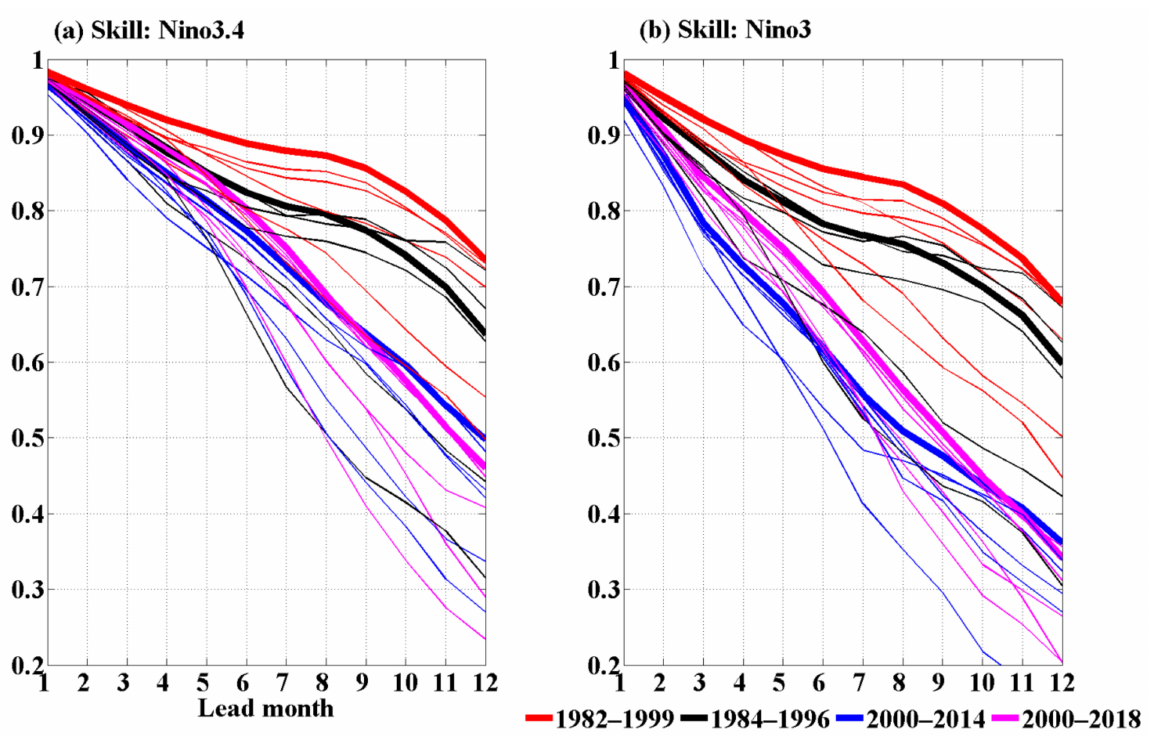
Figure 1. Temporal correlation between the multimodel ensemble (MME) forecasts and the observations for all of the months combined as a function of lead time for ( a ) the Niño3.4 index and ( b ) the Niño3 index for the four periods. (The thick solid lines indicate MME results and the thin solid lines indicate the results of the five individual models. The different colors indicate the results for the four periods, as shown in the